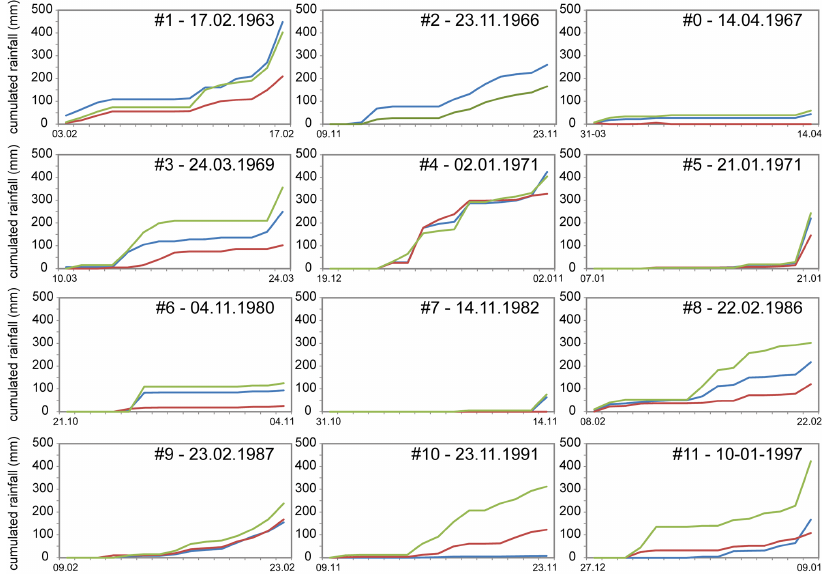
Figure 7. Cumulative daily rainfall (in mm) during the 14 days preceding landslide occurrences. Key: in blue, red, and green: values from the Tramonti, Castellammare, and Tramonti-Chiunzi rain gauges, respectively. Numbers refer to id. in Table 1 (cf. first